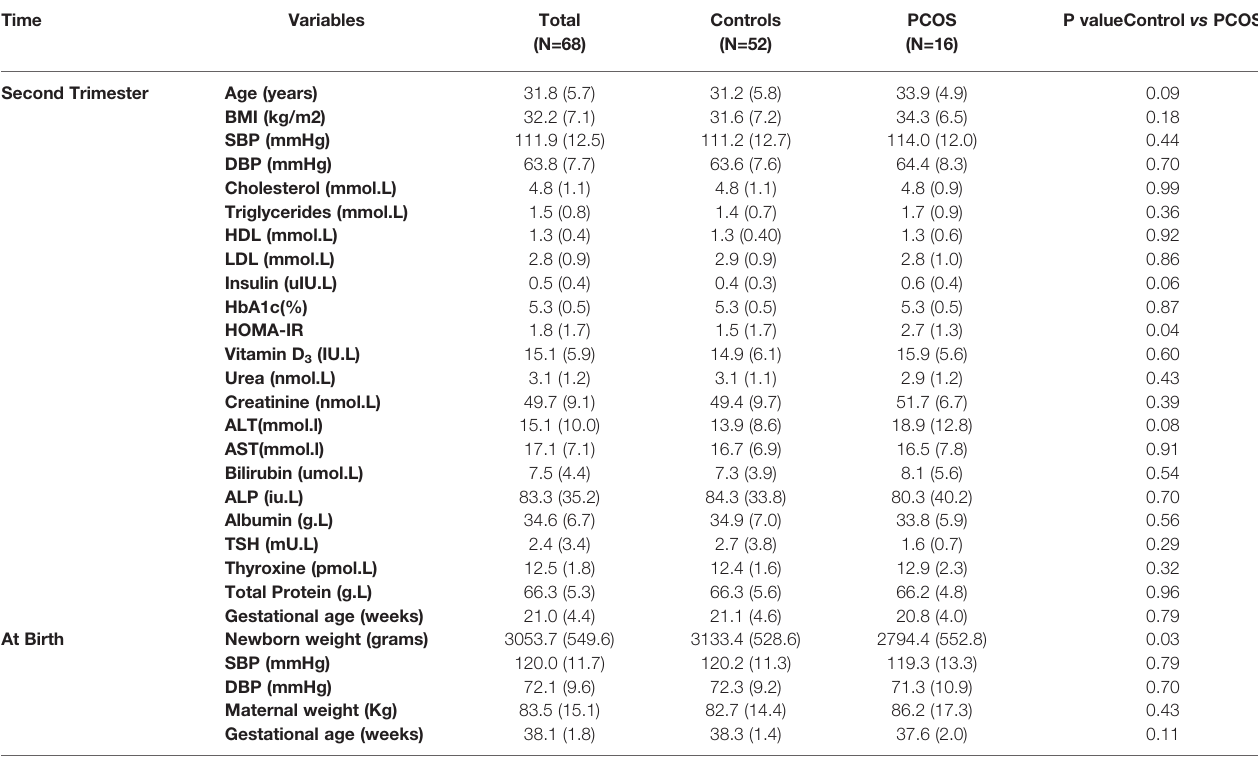
TABLE 1 | General characteristics of study participants. Time Variables